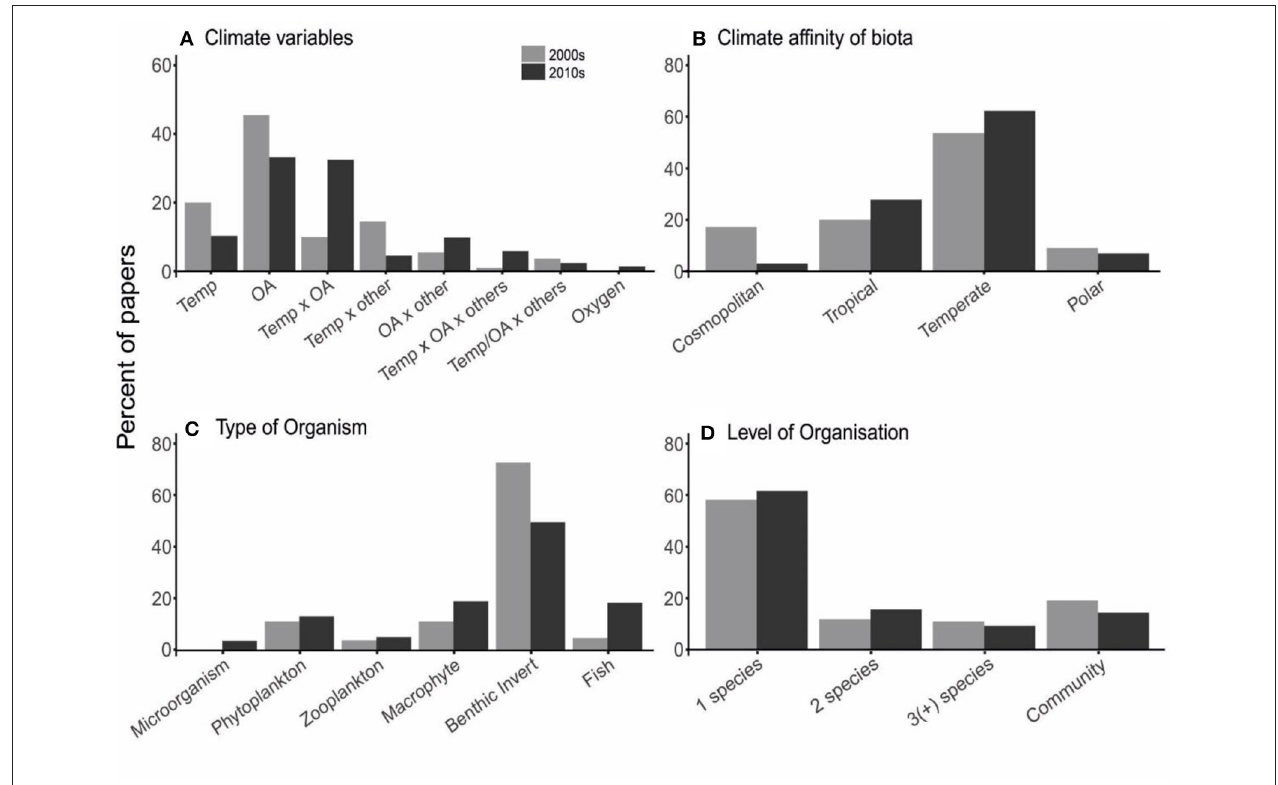
FIGURE 3 | Characteristics of Marine Climate Change Experiments (MCCEs) published in two decades (2000–2009 vs. 2010–2019), shown as a percentage of total research effort in each decade. Studies were classified by (A) the climate variables that was experimentally manipulated, (B) the climatic region of which the study organism(s) belonged, (C) the type of organism (experiments with multiple types were recorded more than once) and (D) the number of species studied. In panel (A) “Temp” = temperature, “OA” = ocean acidification, “Oxygen” = deoxygenation experiments. In panel (D) numerals donate number of species/taxa studied, “comm” = community level experiment (as reported by